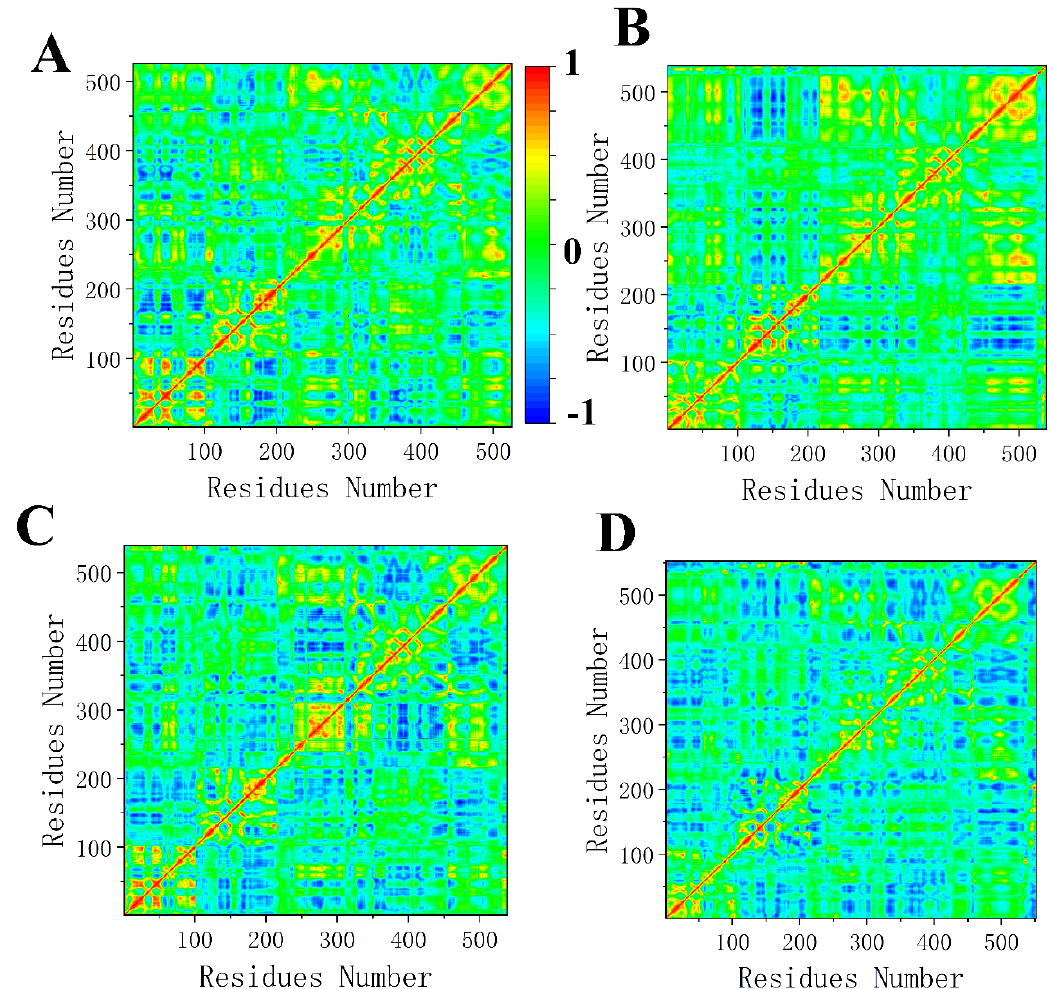
Figure 9. The cross-correlation maps of system SHP2 ( A ), system EPIYA-D-N ( B ), system EPIYA-C-N ( C ), and system EPIYA-C-DUAL ( D ). The covariance values are within the range of − 1 to 1, where the 1 reflect the pairs of residues moving in the same direction. The − 1 reflects those residues moving in the opposite direction.